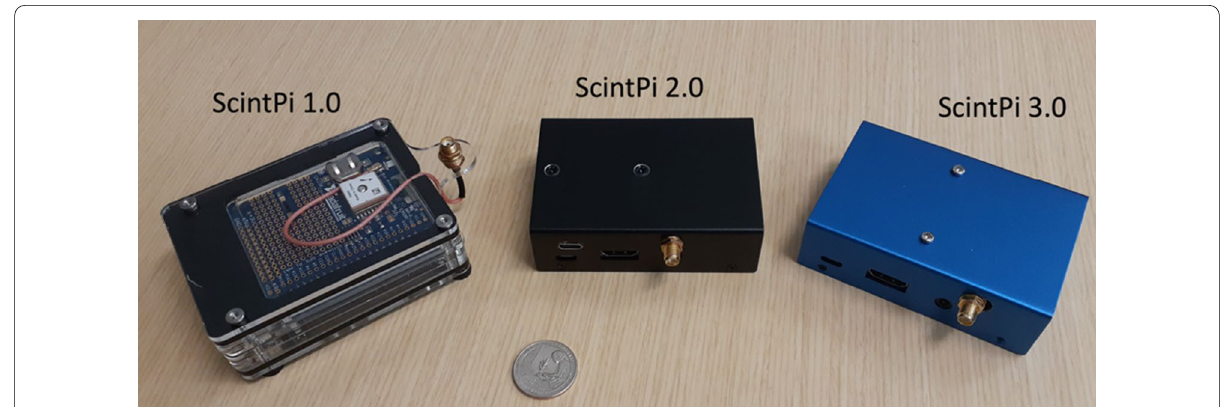
Fig. 1 The three versions of ScintPi ionospheric monitors. ScintPi 1.0 was described by Rodrigues and Moraes (2019). ScintPi 2.0 and 3.0 are introduced in this report